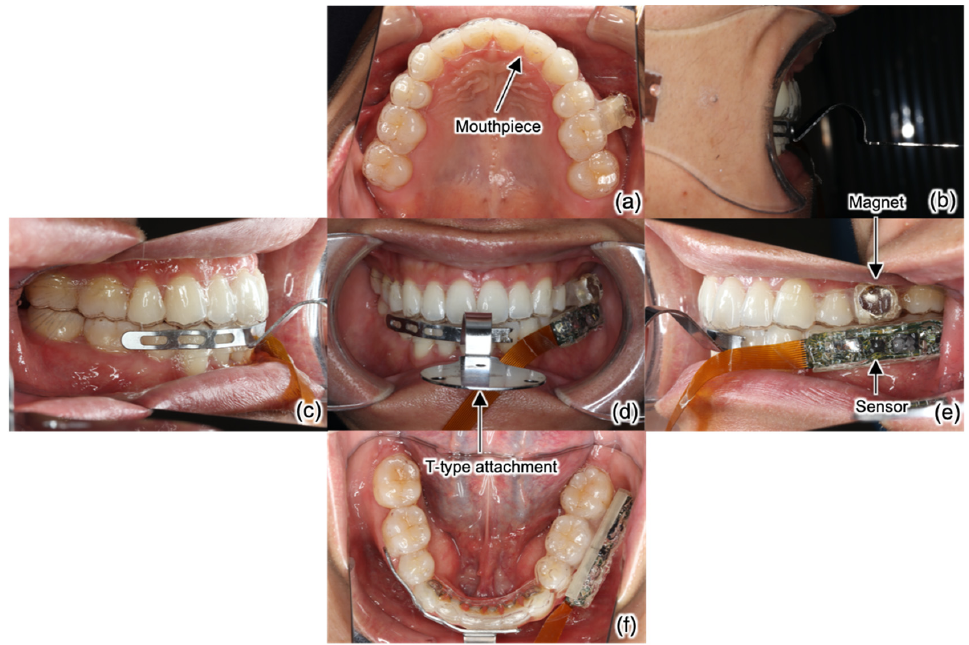
Figure 9. Intraoral photographs during simultaneous measurement with the present sensor and the WinJMA system. ( a ) Upper teeth; ( b ) overjet; ( c ) right lateral teeth; ( d ) frontal view; ( e ) left lateral teeth; ( f ) lower teeth.